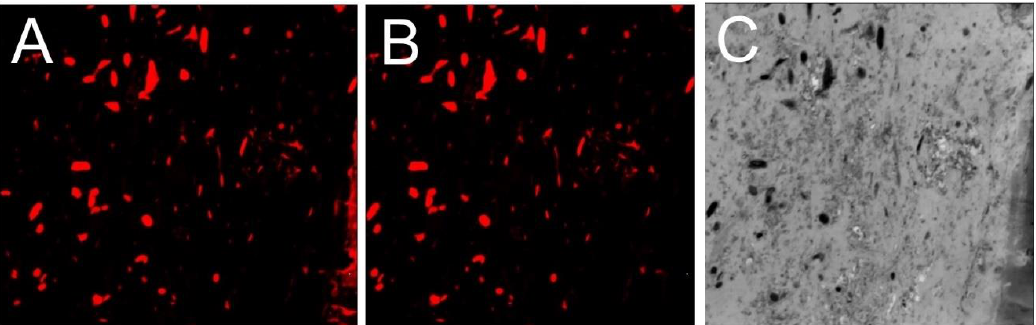
Figure 4. Ice removal using Fiji: ( A ) Upper section of probability map for RWSN, slice 88. Ice (lower right corner) is included in the segmentation. ( B ) Same section after manual ice removal. ( C ) Image of the same section before segmentation for comparison. Belowground biomass is displayed in dark pixels hues, as the image is inversed.